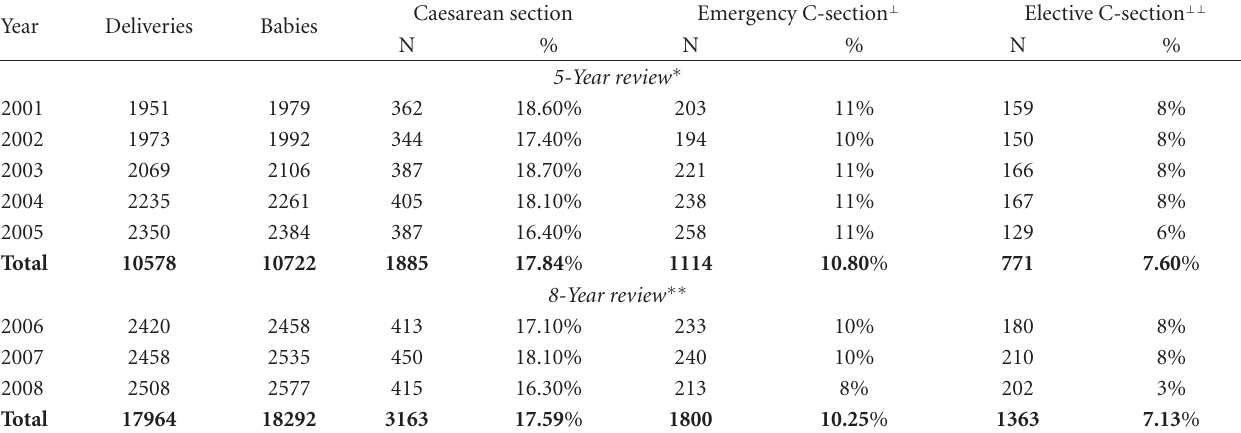
Table 1: Eight-year review of caesarean sections-Diana, Princess of Wales Hospital, Grimsby UK ⊥